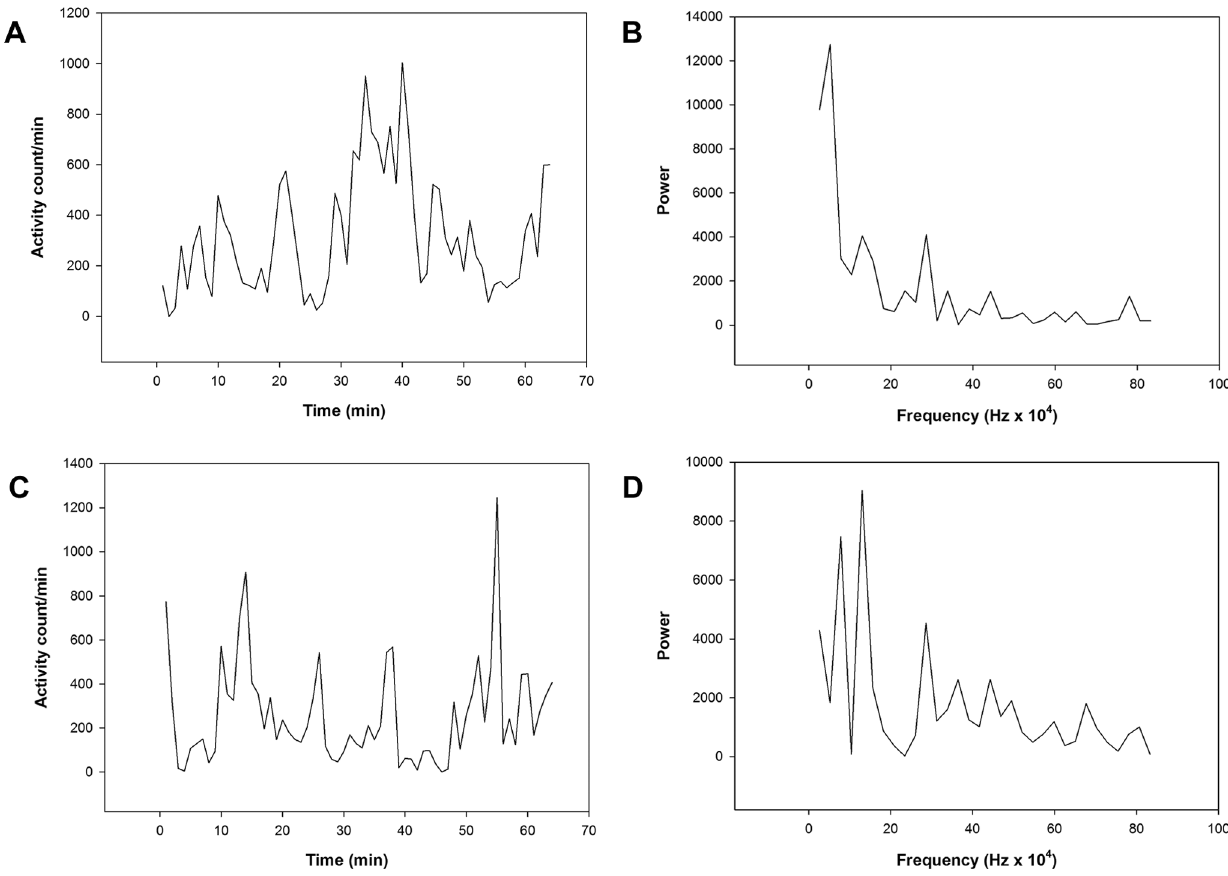
Figure 2. Actigraphy recordings of 64-minute periods of continuous motor activity in the morning. Activity counts and Fourier analysis from a healthy control (A and B) and a patient with mania (C and D). doi:10.1371/journal.pone.0089574.g002 The patients with depression are less active than healthy a common factor in depression [10]. Also, both patient groups are controls over 24 hours, which corresponds with low activity being less active than the healthy controls during a 64-minute period of